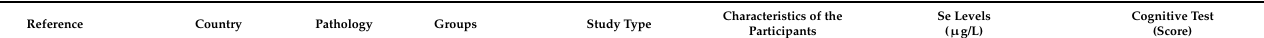
FormulaF Pre: 23.2 ± 1.1 Post: 24.3 ±